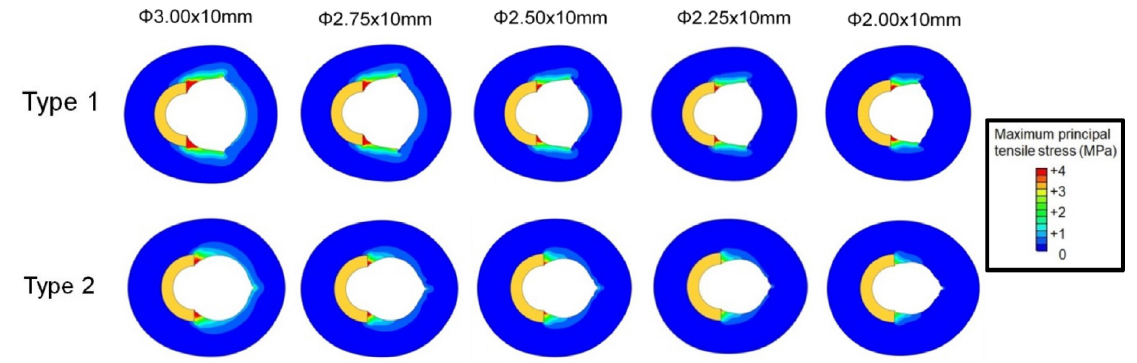
Fig 5. Stress distributions in the artery model for Type 1 and Type 2 at the rated pressure (12 atm) for five different balloon diameters.